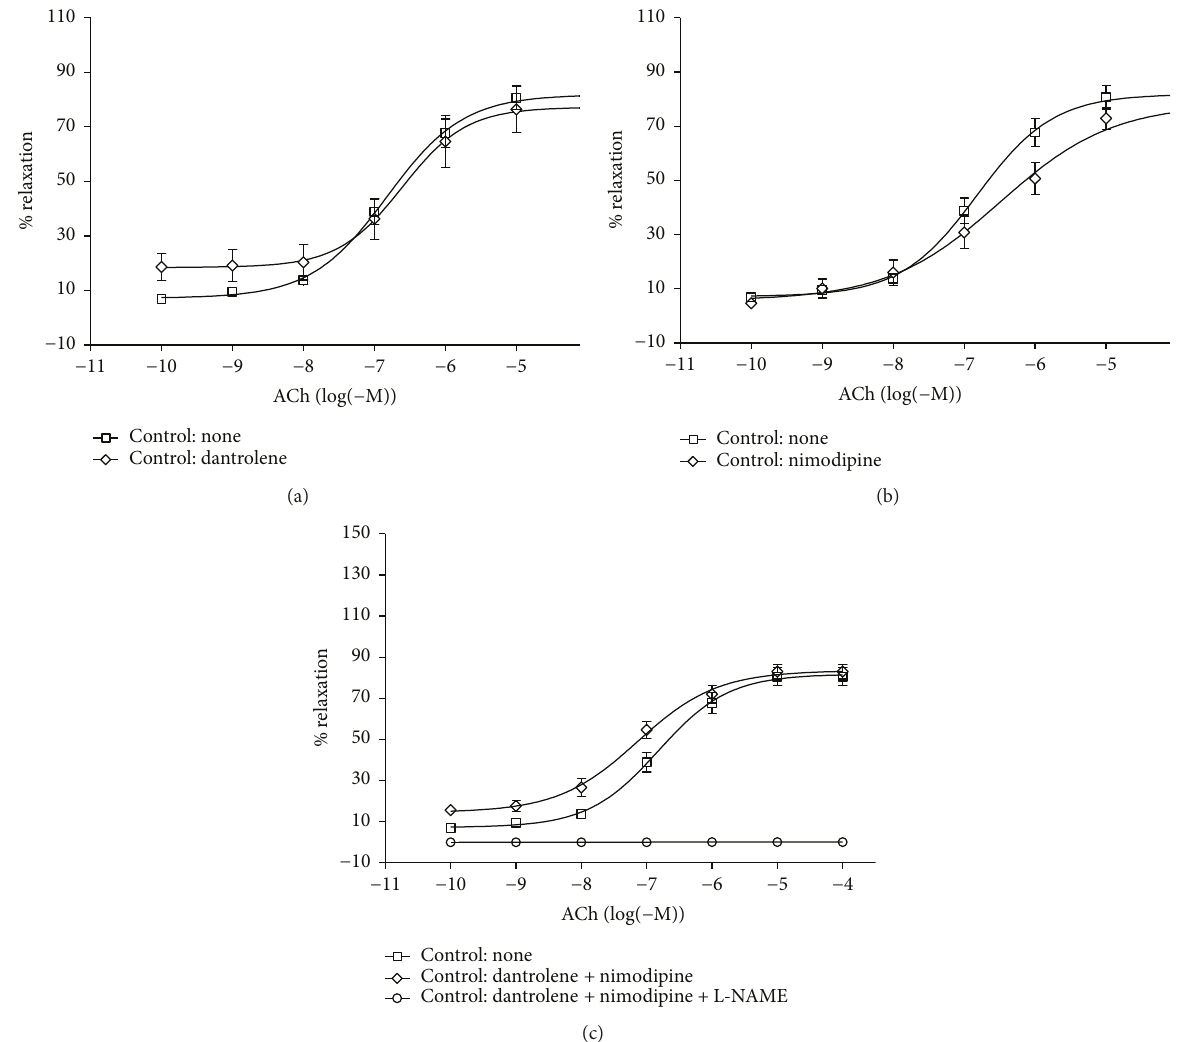
Figure 3: Cumulative concentration-response curves for the acetylcholine- (ACh-) induced relaxation of aortic rings from control rats (CT) only after a 30min incubation period with 50 μ M dantrolene (a), with 50 nM nimodipine (b), and with both drugs in combination (c). Aortic rings were precontracted with 0.1 μ M phenylephrine (PHE) before the addition of cumulative concentrations of ACh. The values shown are the means ± SEM of 6 to 9 animals per group. Note that the addition of 1mM L-NAME to the incubation bath inhibited the ACh-induced relaxation of aortic rings from dantrolene and dantrolene+nimodipine-treated control